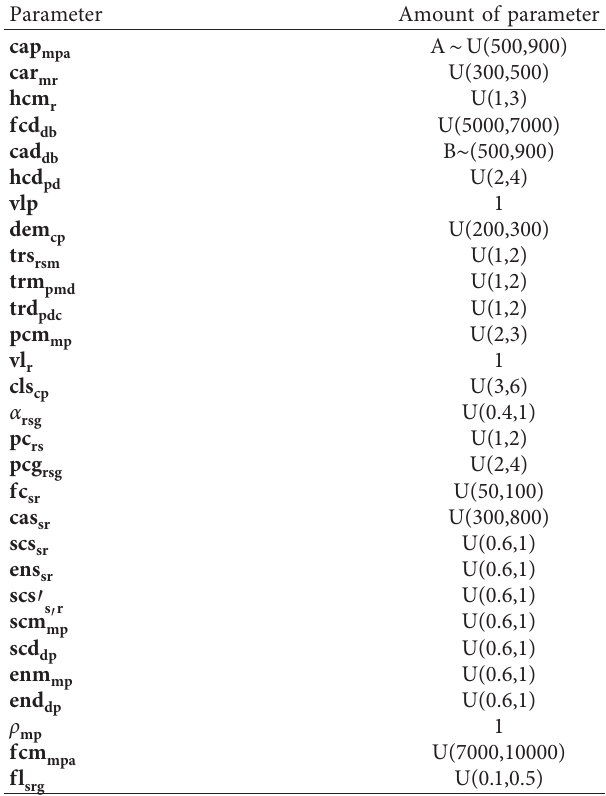
Table 3: The amount of input